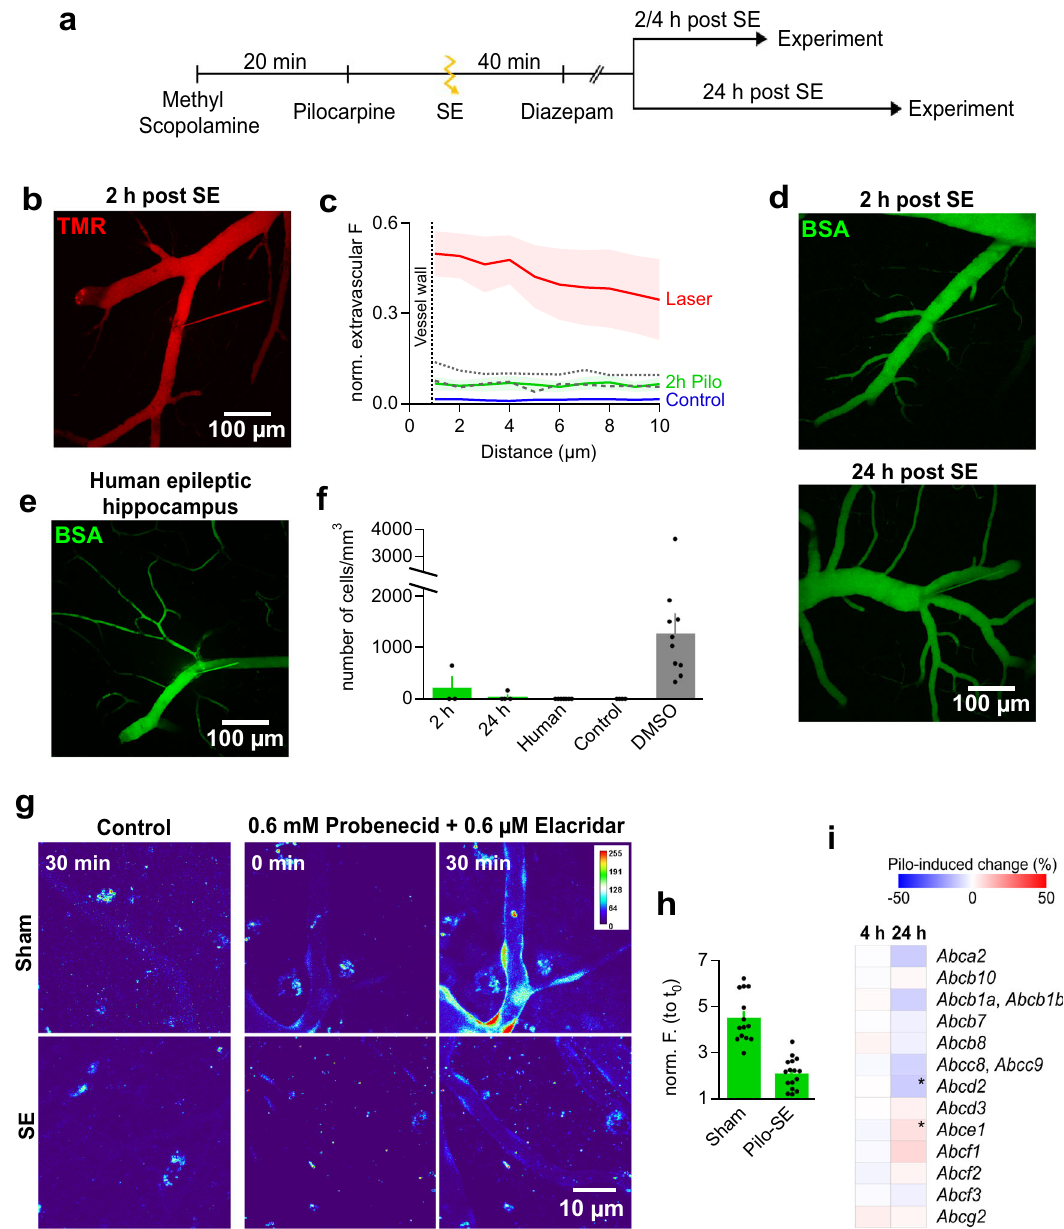
Fig. 7 | BBB in temporal lobe epilepsy. a Timeline of pilocarpine experiments. b MIP after TMR injection at 2h post SE, quanti fi ed in (c). c , Fluorescent pro fi les across walls of capillaries. Comparison across conditions, mannitol (dotted line), DMSO(dashedline). d MIPsofBSA-Alexa488(BSA)-injectedbrainmicrovasculature assessed 2h (top) and 24h (bottom) post SE. e MIP of BSA- fi lled microvasculature within a human hippocampal brain slice. Image is representative of 7 injections performed in hippopcampi of 5 TLE patients who underwent neurosurgical treat- ment of their epilepsy. f Quanti fi cation of BSA-Alexa488-loaded macrophages in the murine epileptic condition at 2h ( n =3) and 24h ( n =4). Data are compared to those obtained from human ( n =7), control ( n =4) and DMSO ( n =10) samples. g , MIPs ofcapillaries ofsham(top row)and 2hpost SEmurine slices (bottom row) without preincubation with blockers (control) at t 30 and under full ABCC1/partial